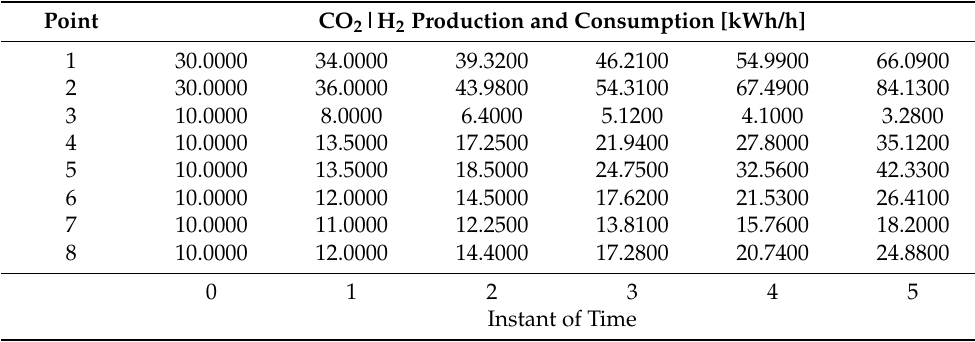
Table 6. CO 2 |H 2 production and consumption values for the pipeline network between the instants of time 0 and 5 with W F = 0.25 and W B = 1.0.